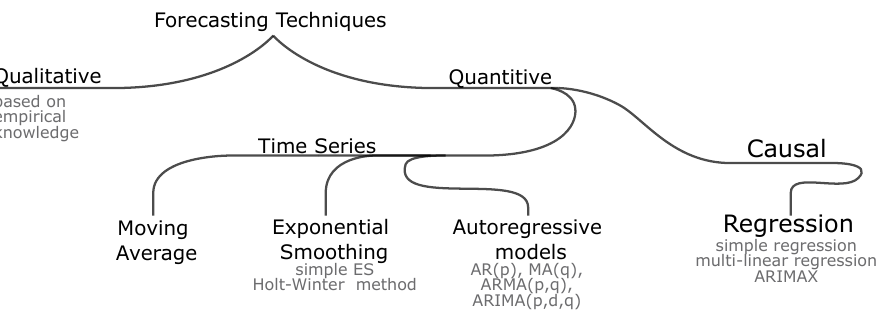
Figure 1. Classification of time series forecasting techniques.